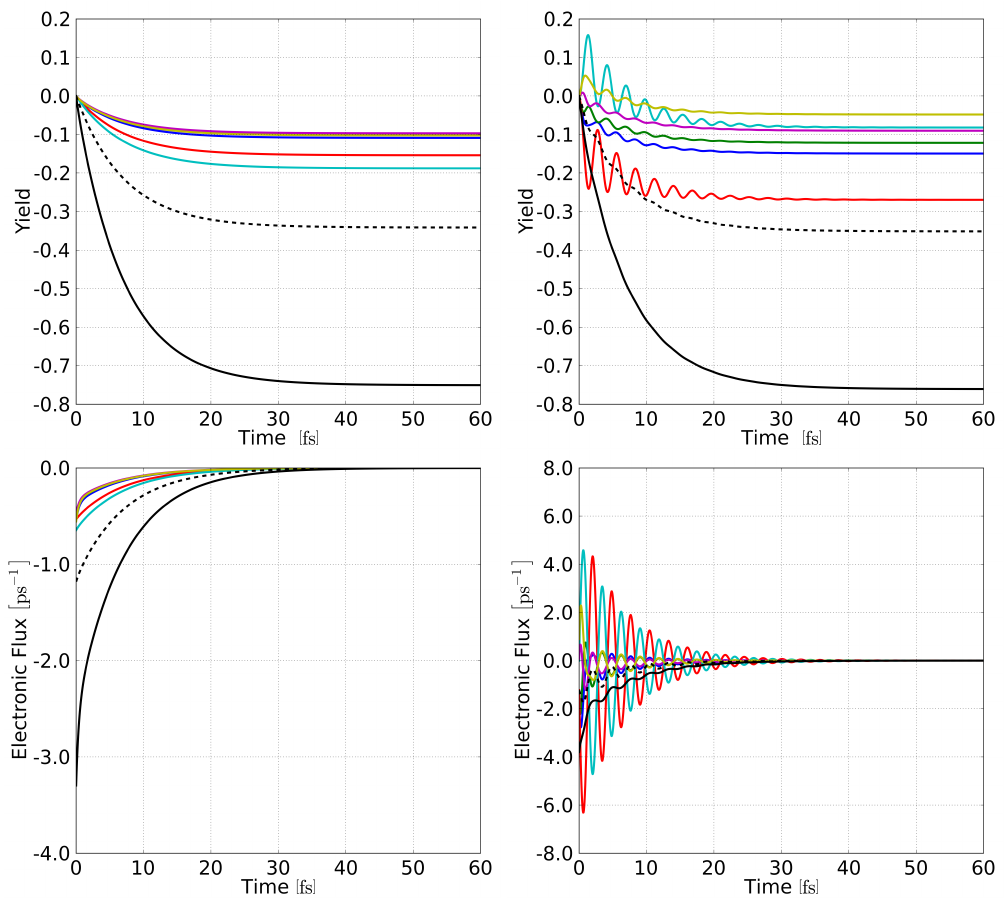
Figure 5. Evolution of the electronic yield, Equation (15), and associated flux, Equation (14), during the charge transfer dynamics from the alizarin towards the TiO Projectors on the Outer Top ring (blue), Outer Bottom ring (green), Inner Top ring (magenta), Inner Bottom ring (yellow), Top Carbonyl (red), and Bottom Carbonyl (cyan) are depicted, as well as the projector on the central unit (dashed) and the complete alizarin (solid black). Left panels: incoherent propagation of the electronic density. Right panels: coherent propagation of the electronic wave